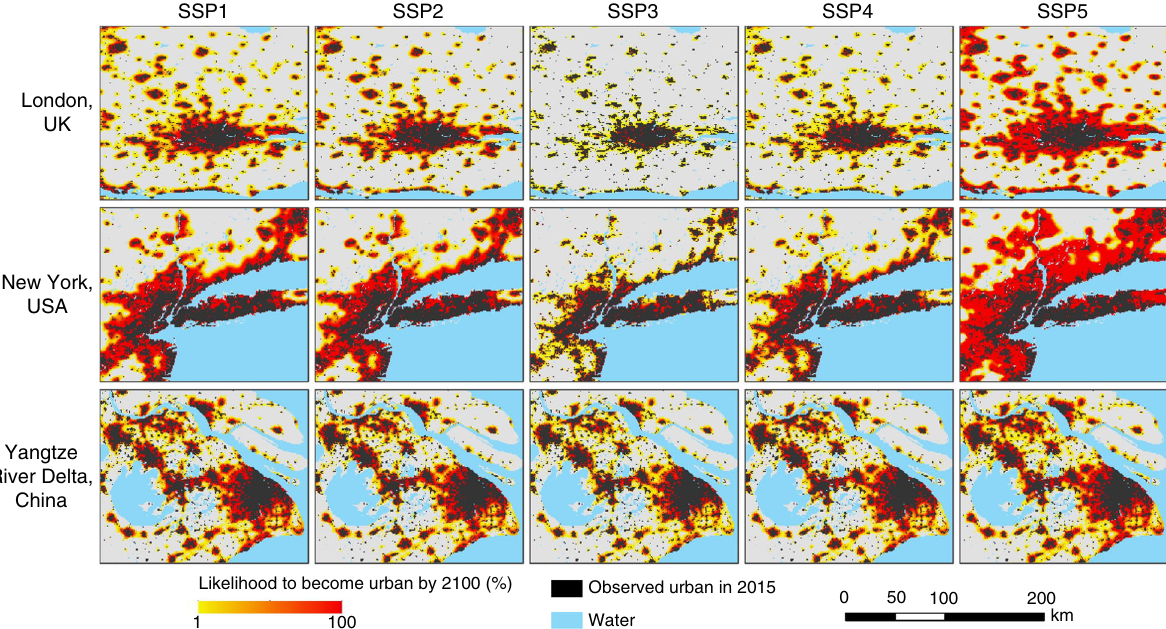
Fig. 3 Uncertainty in the simulation results of three major metropolitan areas in 2100. This fi gure shows the likelihood of each grid to become urban, which is estimated by overlapping the results of 100 simulation runs. Grids with higher agreements of simulated growth among the 100 simulation runs are assumed more likely to become